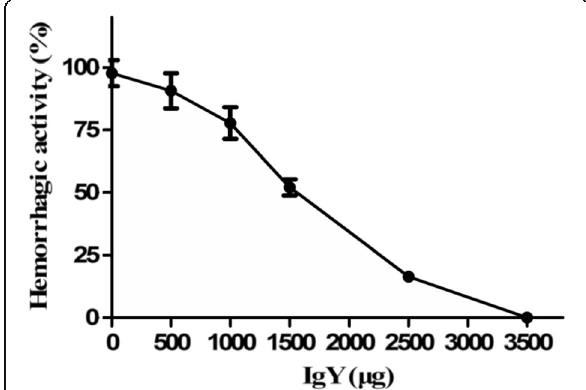
Fig 6 Neutralization of hemorrhagic effects of D. acutus venom by IgY (mean ± SD, n = 4). Mixtures containing a constant amount of venom and various dilutions of IgY were incubated at 37 °C for 30 min. Afterwards, aliquots of the mixtures (10 μ L containing 3 MHD of venom) were injected subcutaneously into the dorsal skin of mice, whereas control group received the same amount of venom with normal yolk. Hemorrhage was expressed as a percentage, taking as 100% the diameter of the lesions induced by